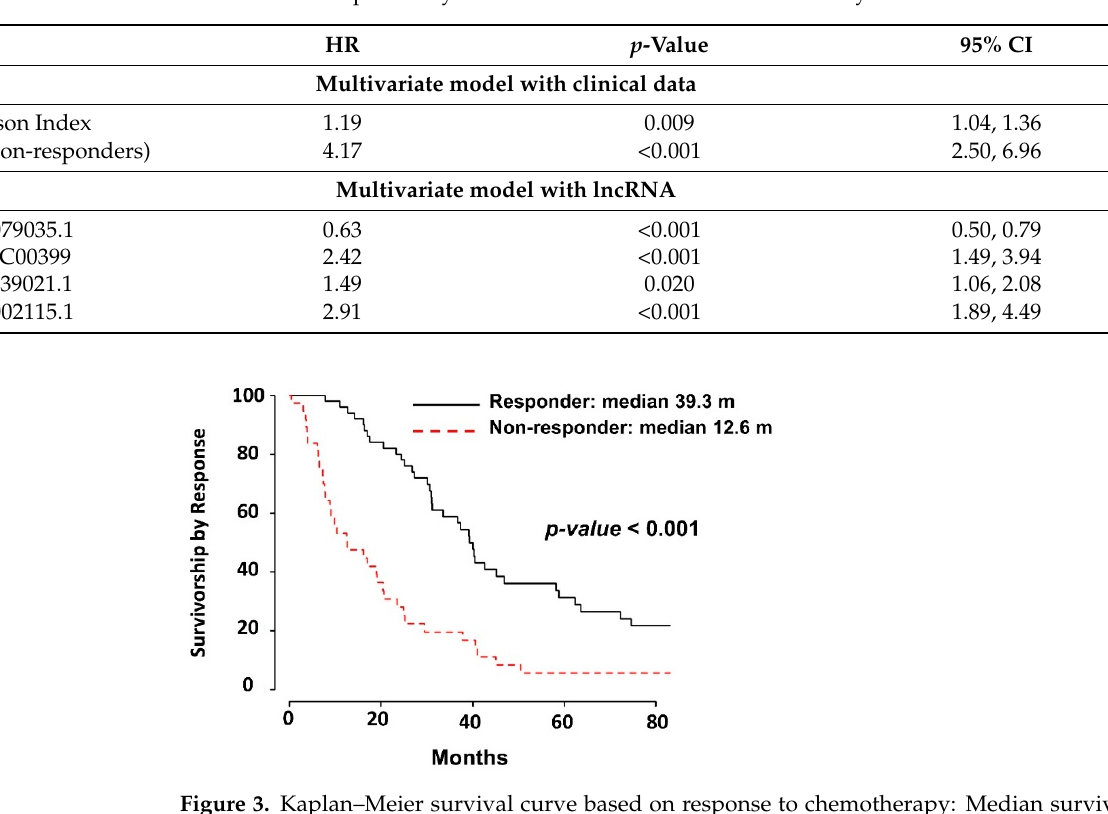
Figure 3. Kaplan–Meier survival curve based on response to chemotherapy: Median survival of